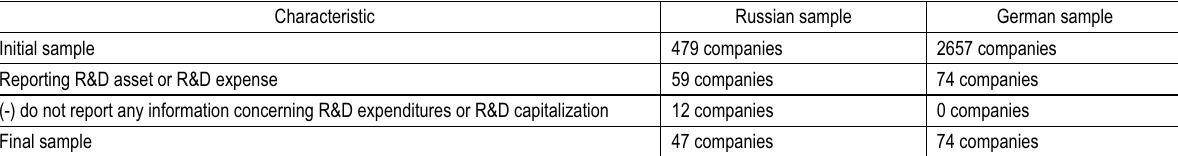
Table 2. Summary of Russian and German samples